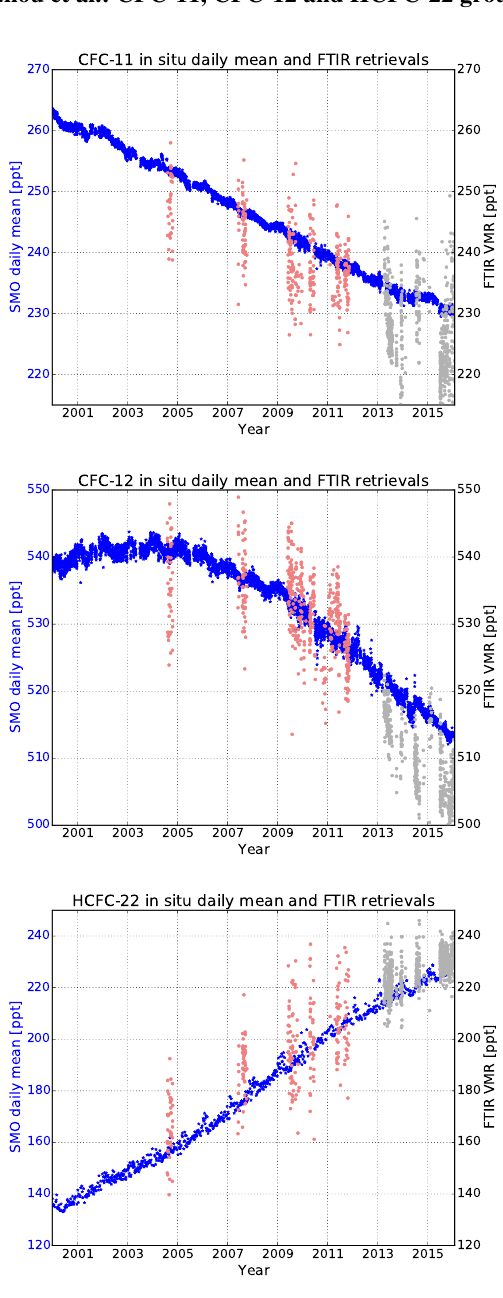
Figure 5. In situ daily mean (CFC-11 and CFC-12) and flask pair 1 measurements (HCFC-22) at SMO site (blue) and individual FTIR column-averaged dry-air mole fractions at St Denis (light coral) and Maïdo (grey). Upper: CFC-11; middle: CFC-12; bottom: